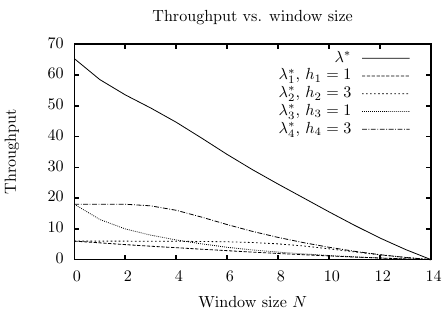
Figure 2: Fairness as function of h c